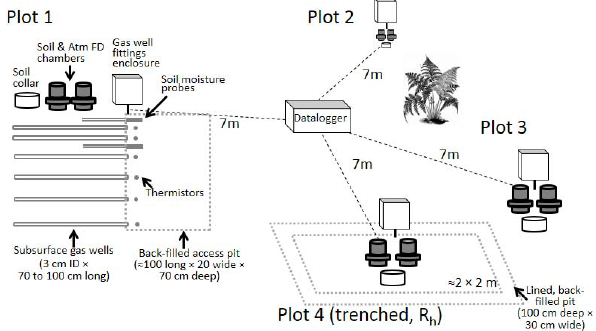
Fig. 1. Schematic of soil plot layout and below ground sensor in-